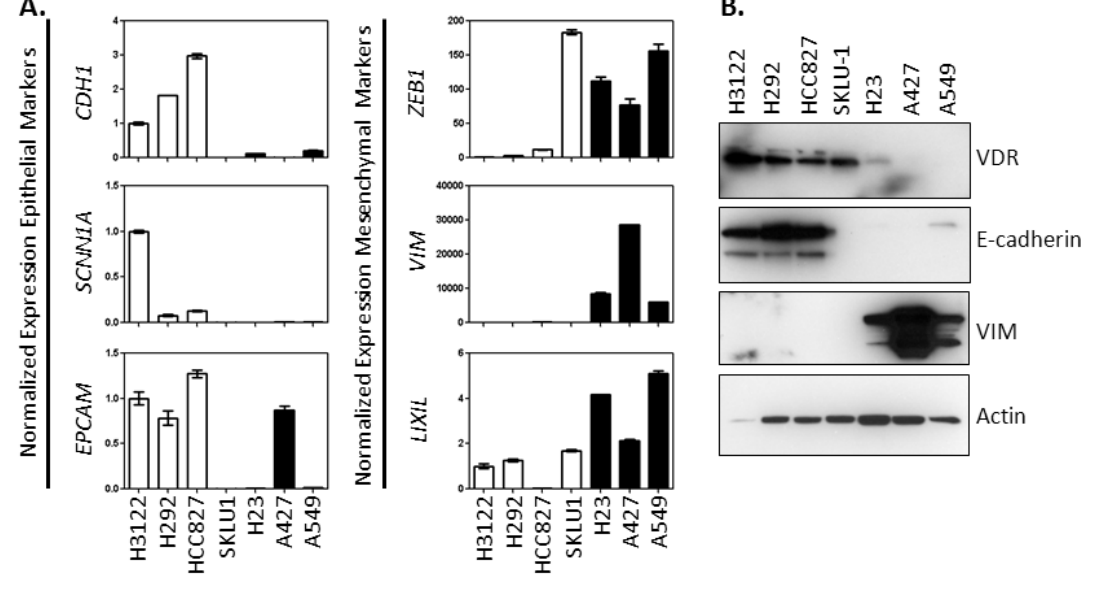
Table 2. Correlation between VDR and EMT Signature Genes in lung cancer cell lines. The correlation between expression of VDR (Affymetrix probe 204254_s_at) and individual EMT signature genes in GEO dataset GSE4824 is